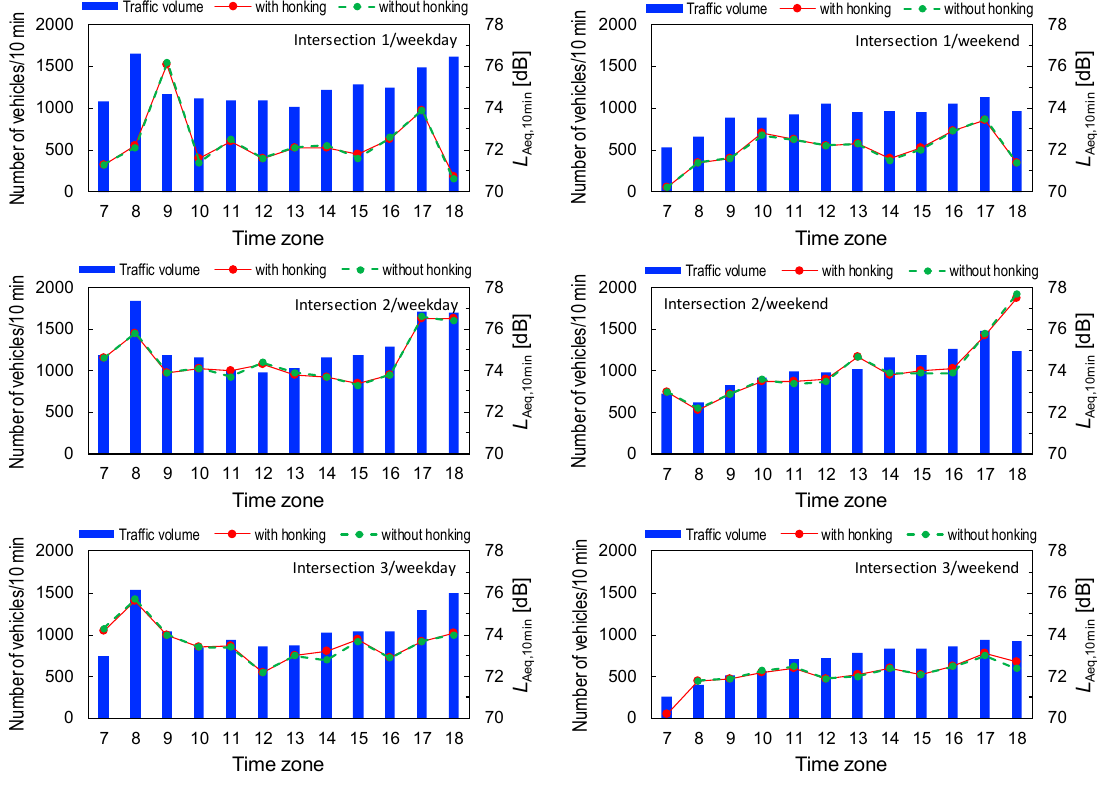
Figure 7. Temporal variations of the total traffic volume and L Aeq,10min .